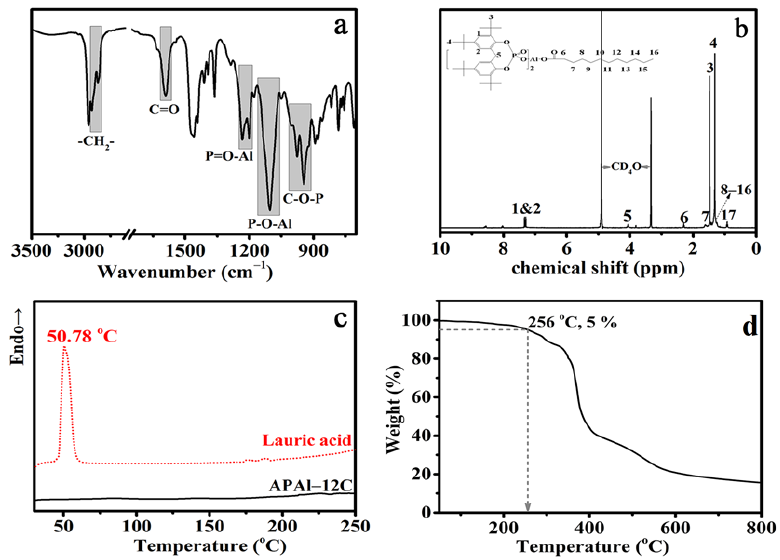
Figure 3. FT-IR ( a ), 1 H NMR ( b ), DSC ( c ) and TGA ( d ) spectroscopy of the APAl-12C nucleating